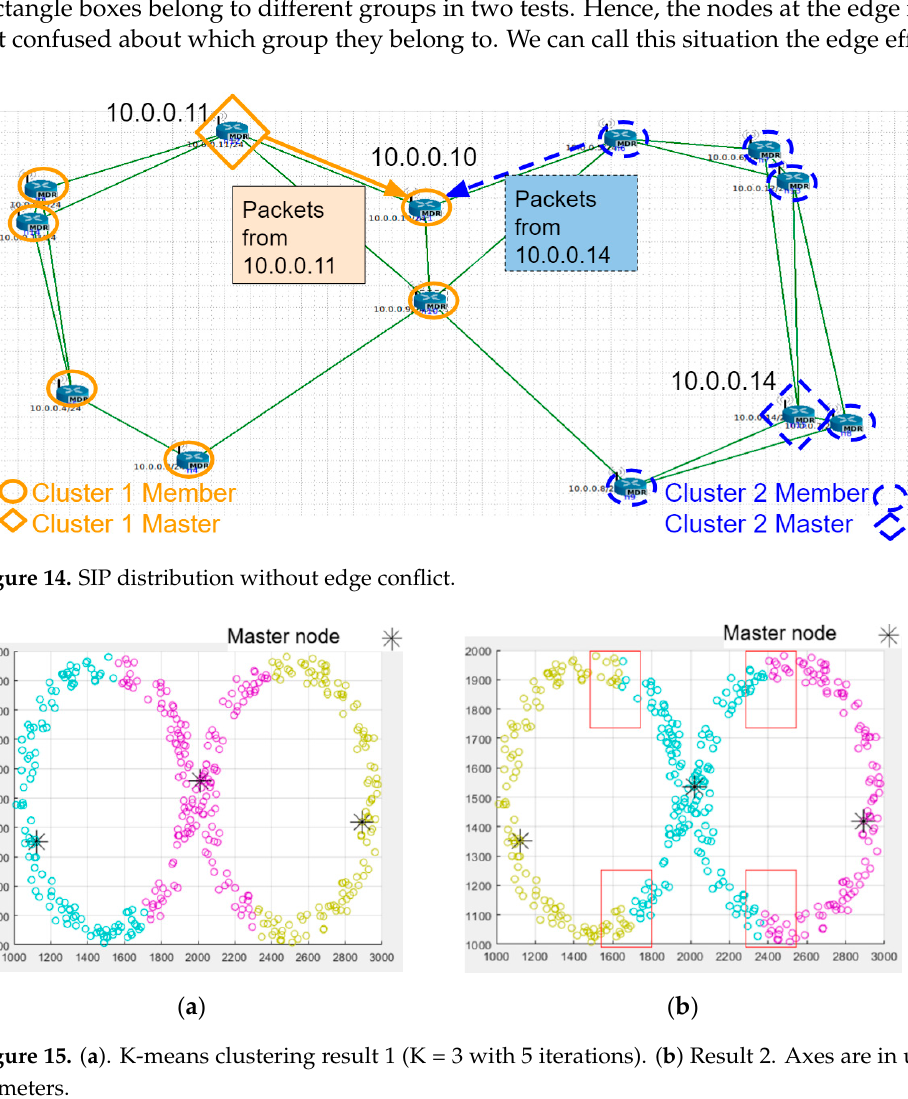
Figure 15. ( a ). K-means clustering result 1 (K = 3 with 5 iterations). ( b ) Result 2. Axes are in units of meters.